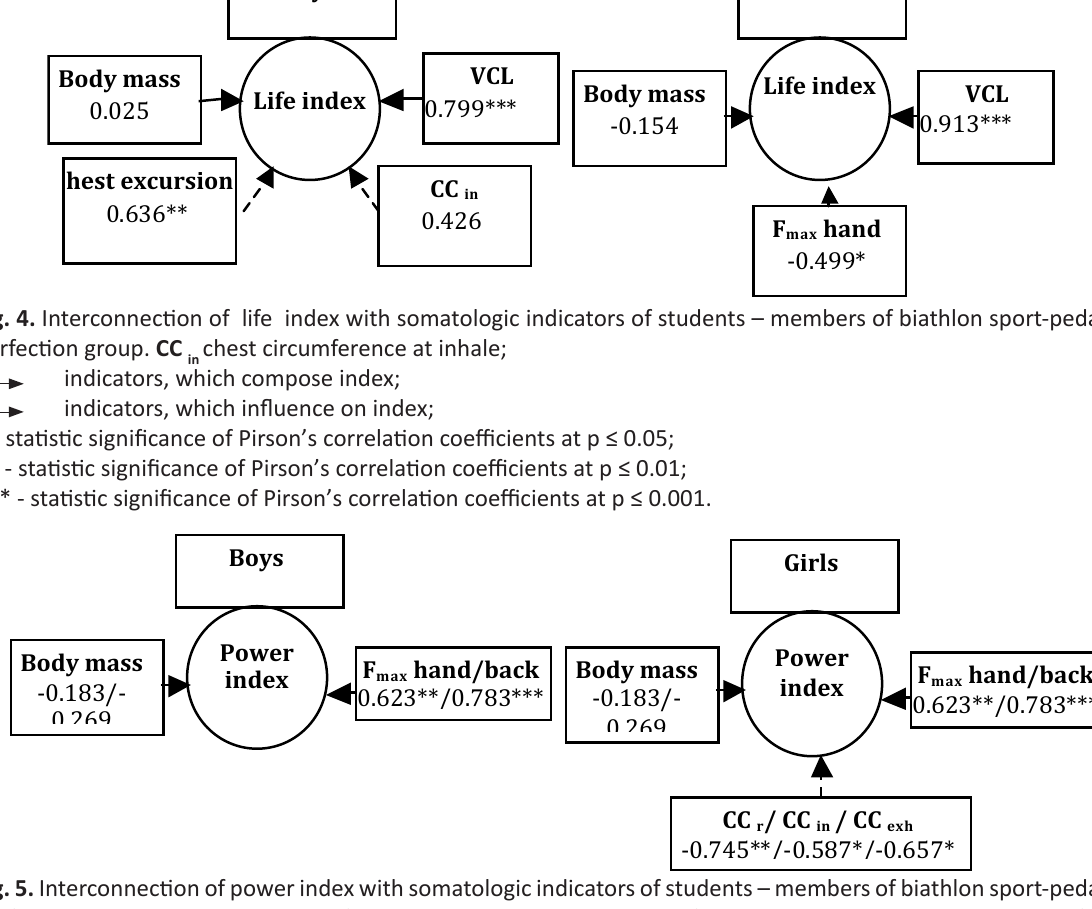
- chest circumference exh